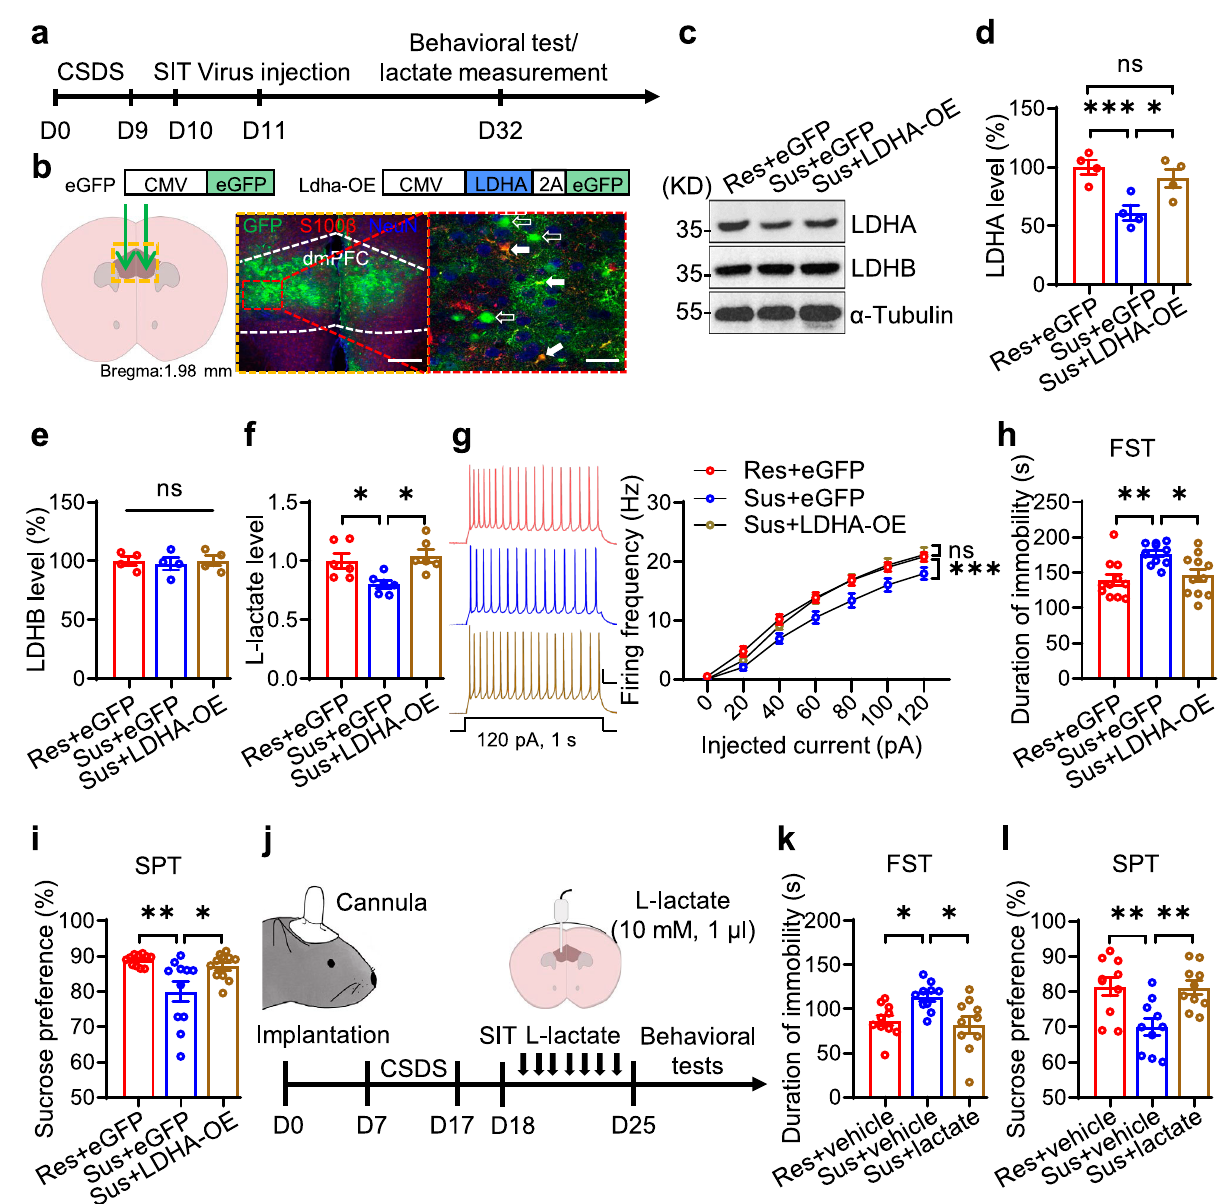
interaction test. b Illustration of viral injections. Solid arrows, GFP + and S100 β + ; hollow arrows, GFP + and NeuN + . Scale bars: 200 µ m, 50 µ m. c – e Representative Western blot images ( c ) and quanti fi cation ( d , e ). n =4 mice per group.